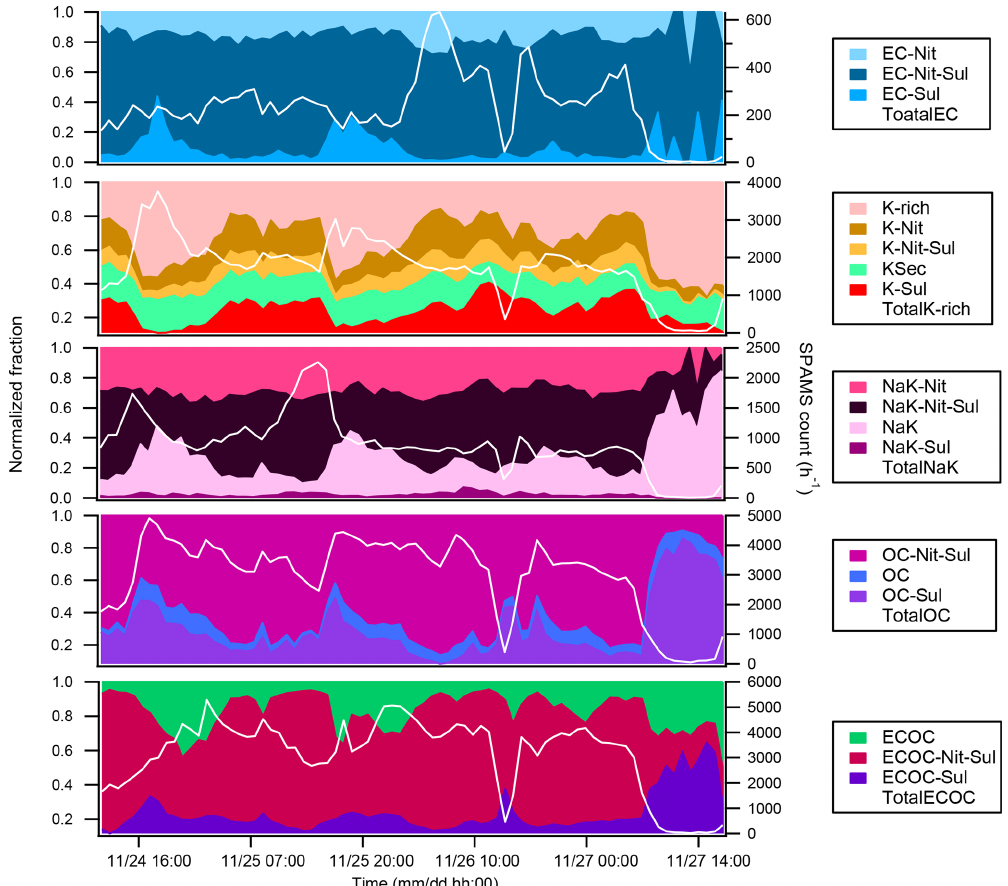
Figure 9. Time trends of number fractions of particle types (left) and hourly counts of particle families (EC, BB, NaK, OC, and ECOC; right) during Pollution Event 4 (E4) at